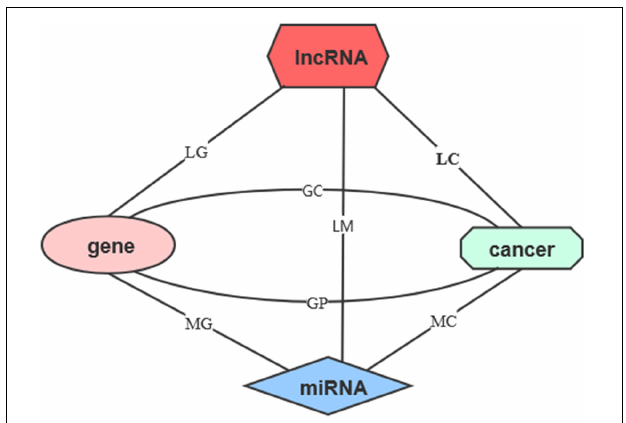
FIGURE 1 | The network of five features. The five features include lncRNAs, miRNAs, genes, cancers, and cancer prognosis. The line represents the relationship